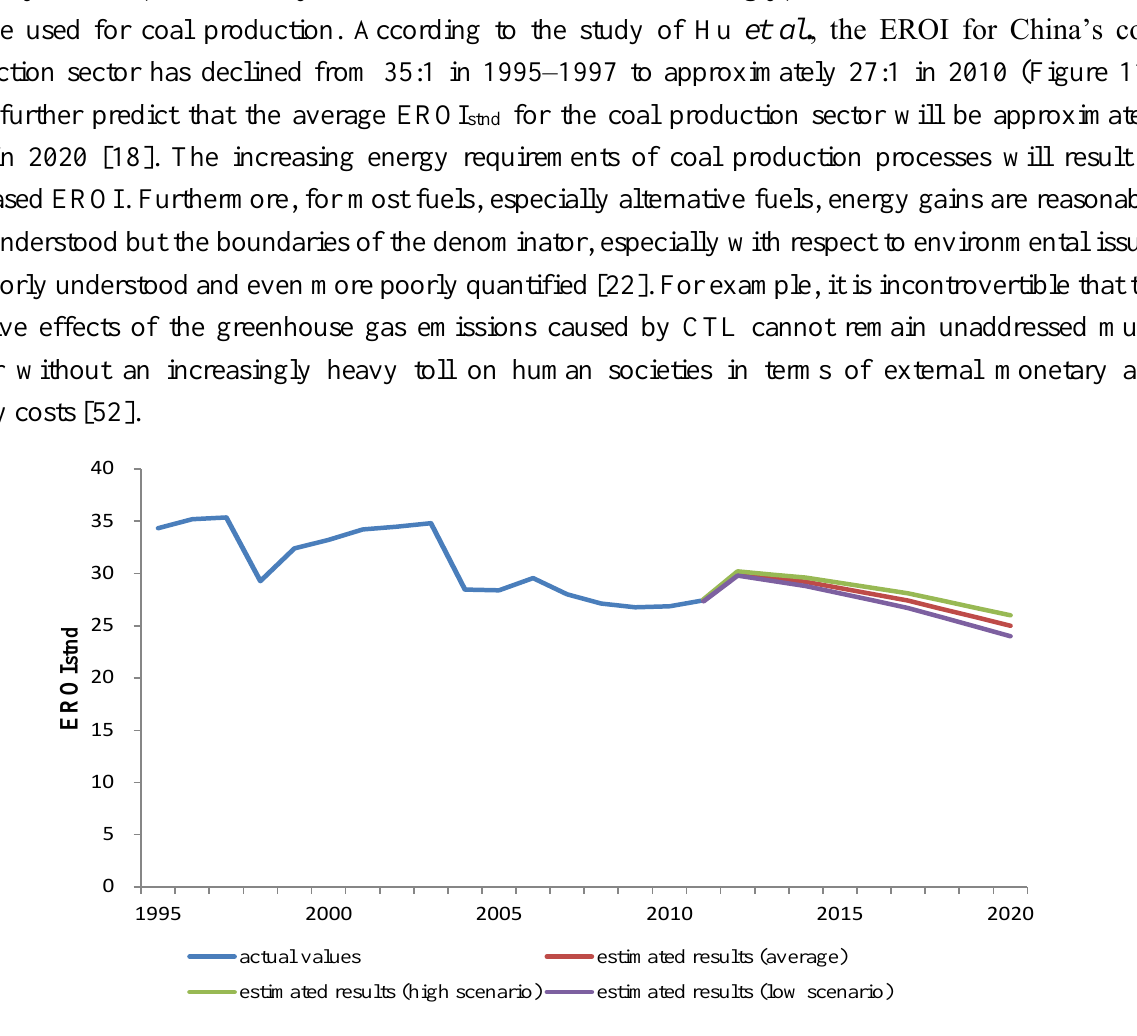
Figure 11. History and forecast of EROI stnd for China’s coal production sector